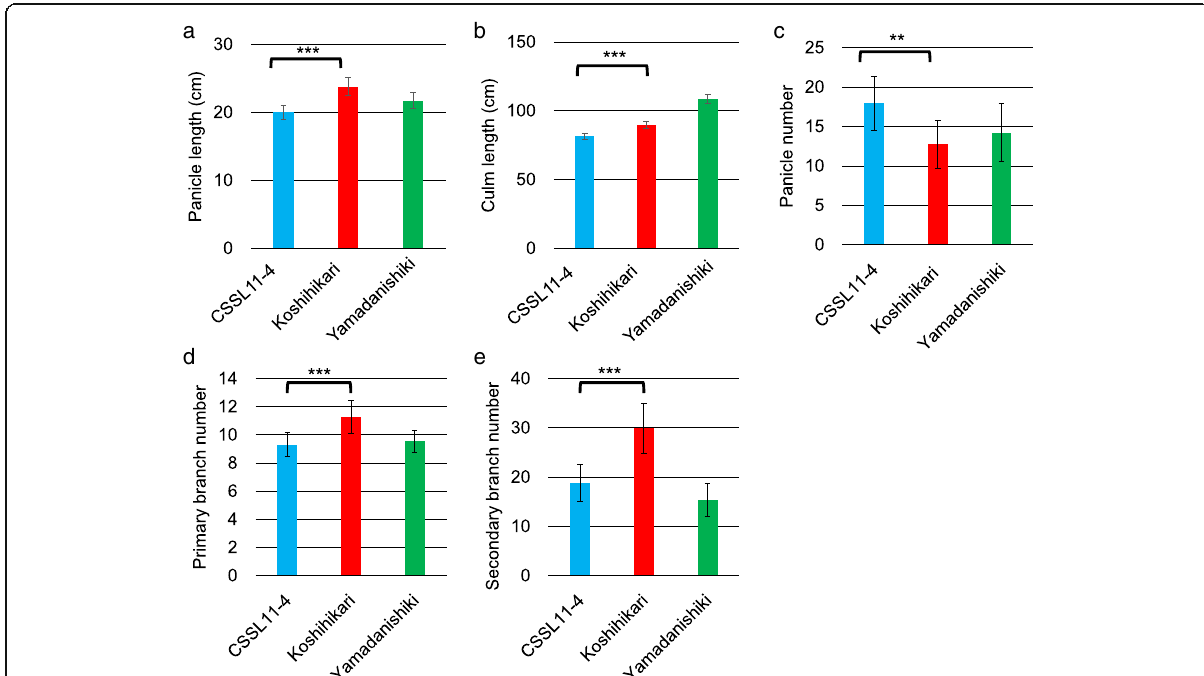
Fig. 4 Pleiotropy of qOPW11 with the panicle length ( a ), culm length ( b ), panicle number ( c ), primary branch number ( d ), and secondary branch number ( e ) of CSSL11 – 4, Koshihikari, and Yamadanishiki. Each trait was tested between CSSL11 – 4 and Koshihikari. ** represents P < 0.01 and *** represents P < 0.001